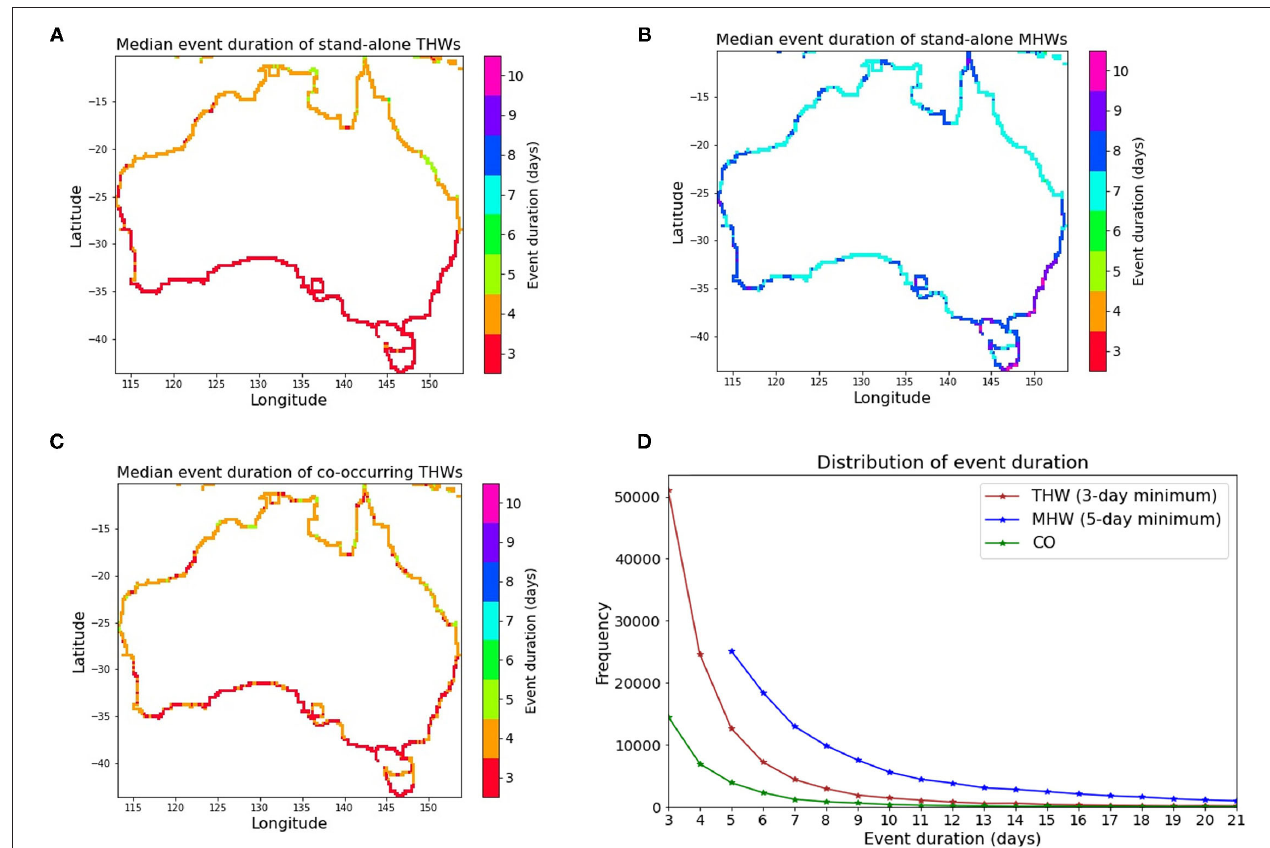
FIGURE 3 | Distribution of median event duration of (A) stand-alone THWs, (B) stand-alone MHWs and (C) co-occurring THWs. (D) Frequency distribution of event duration of terrestrial, marine and co-occurring heatwaves for all 0.5 ◦ grid cells around the coastal belt of Australia from 1982 to